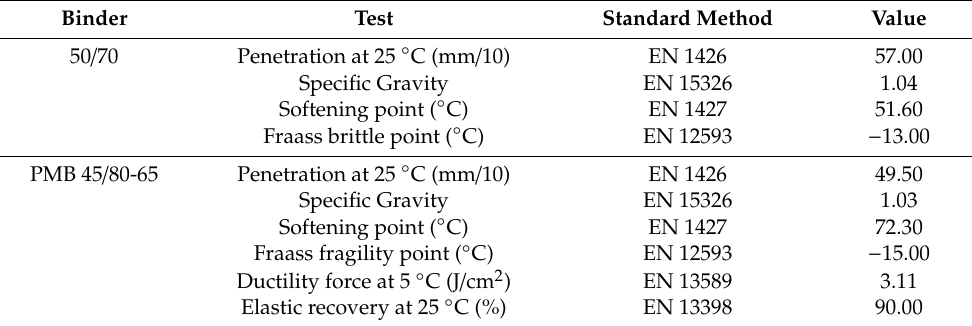
Table 4. Main properties of the binders used.